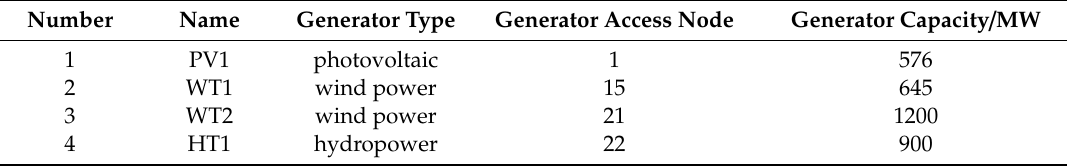
Table A4. IEEE RTS-24 system renewable energy data.